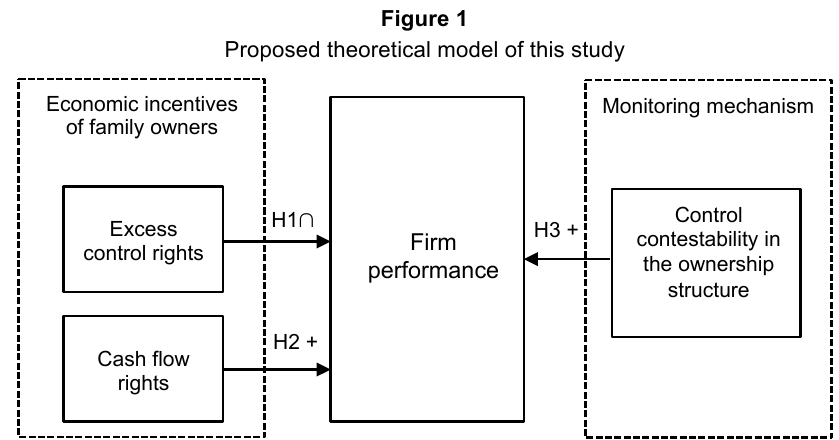
Proposed theoretical model of this study